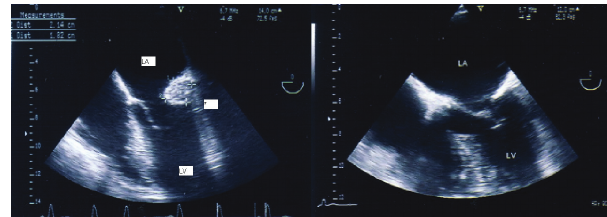
Figure 2 - Transesophageal visualization of the mass (left panel) and trans- esophageal examination repeated nine months later, showing the disappear- ance of the mass (right panel). LV: left ventricle; LA: left atrium; RA: right atrium; Ao: Aorta; *: Caseous calcification of the mitral